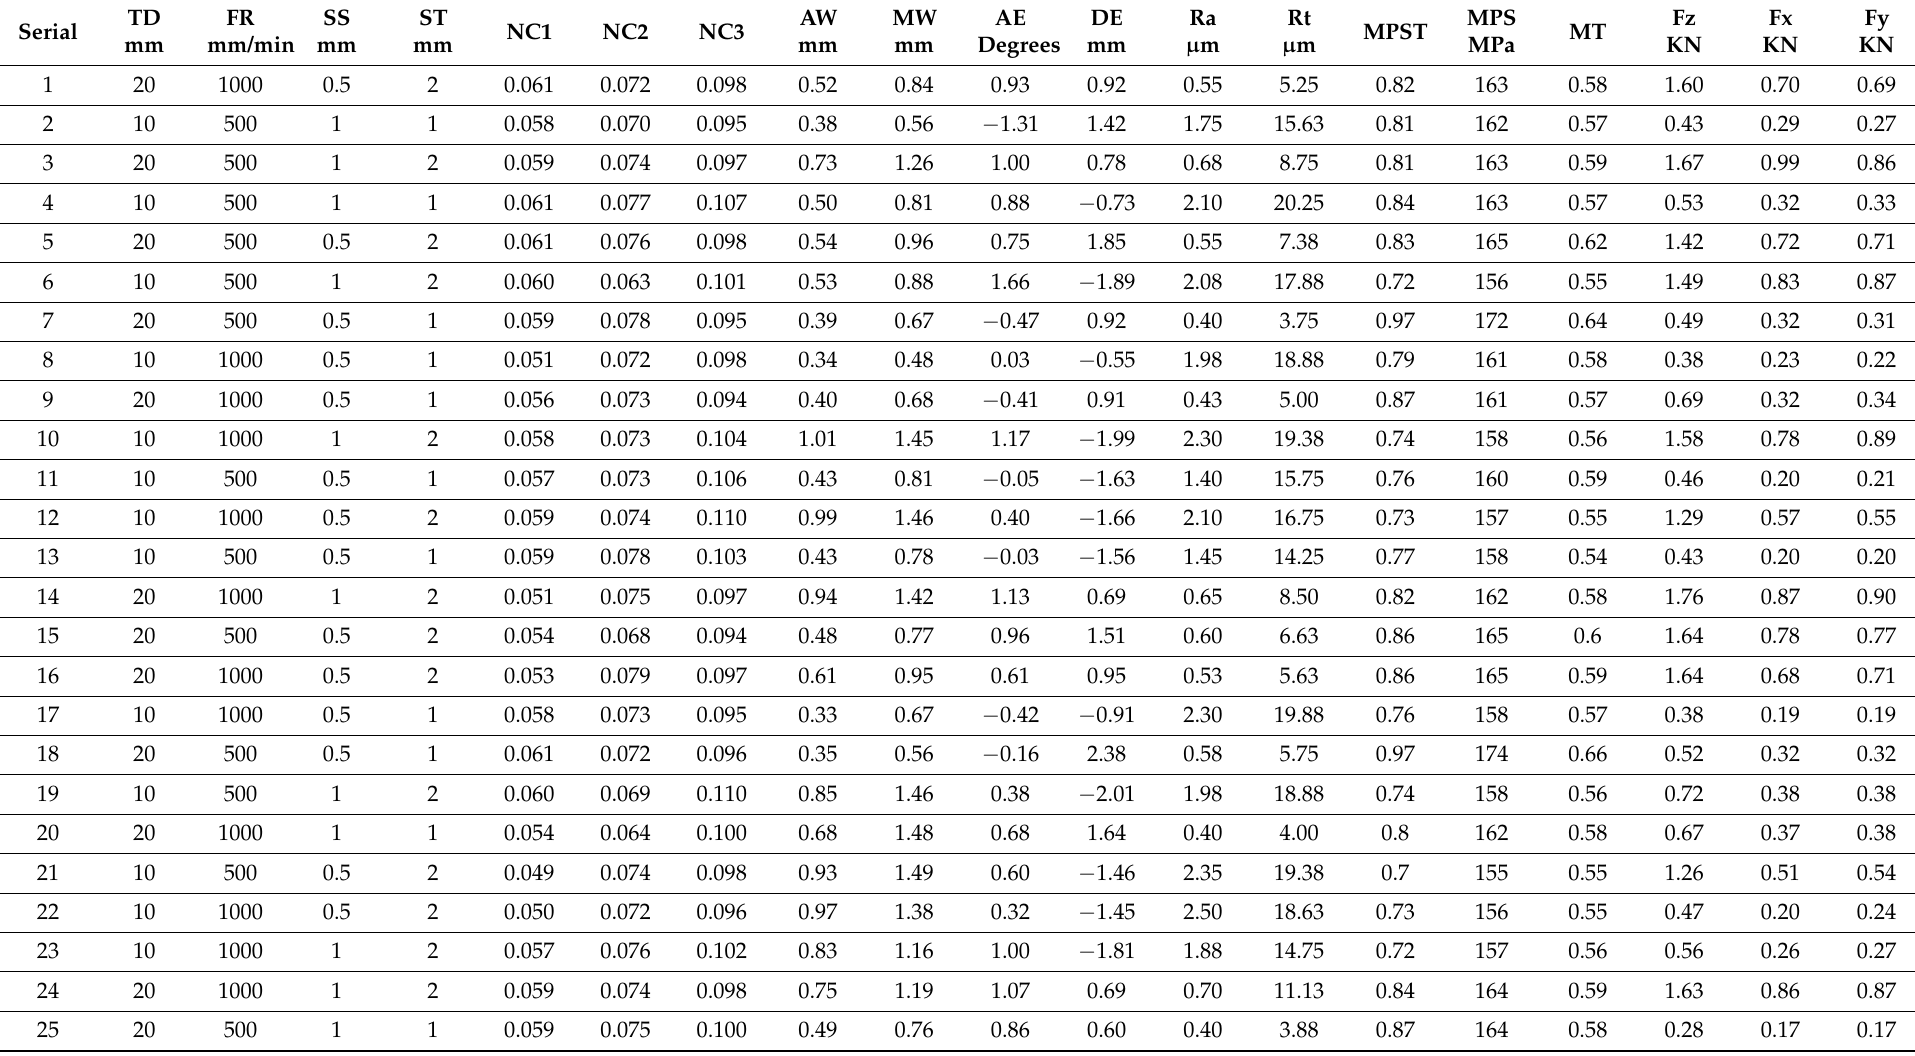
Table 4. Experimental plan and